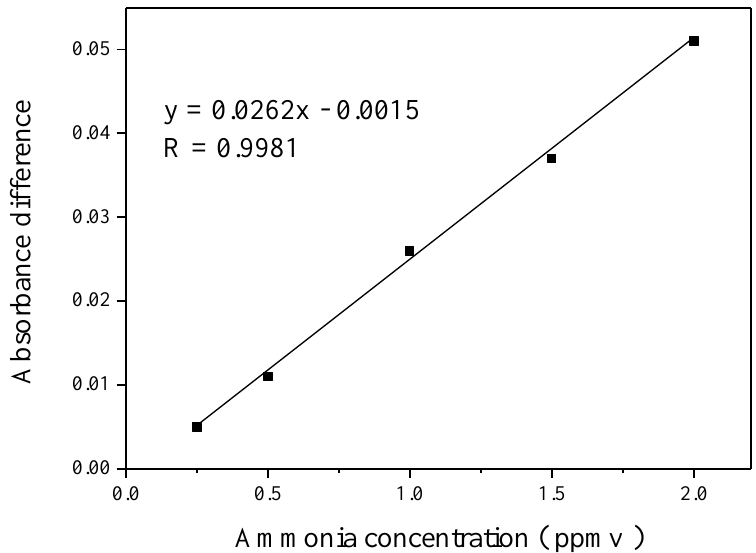
Figure 8. Calibration curve of the Al-MCM-41(50)/BG for sensing sub-ppmv of NH concentration. The test time was 5 min for all NH